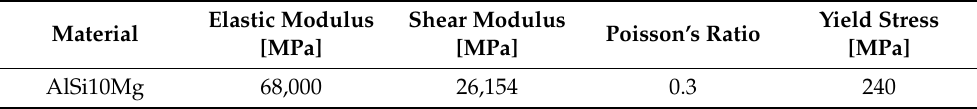
Table 1. Mechanical properties for the bulk material used for specimen fabrication.